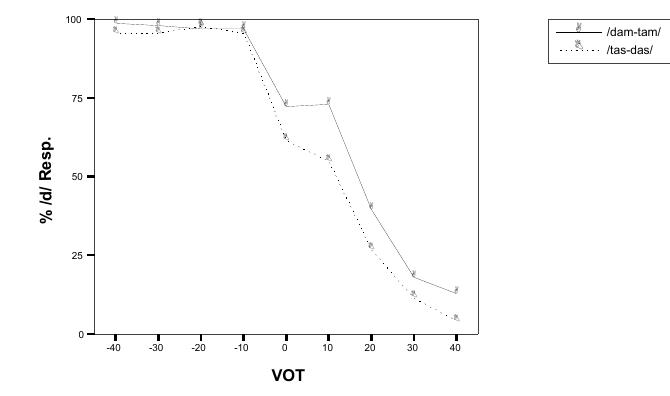
Figure 1: Results of the preliminary experiment. Percentage of voiced responses for stops in initial syllable position in two different word – nonword pairs. In /dam-tam/, /dam/ is a French word and /tam/ is a nonword. In /tas-das/, /tas/ is a French word and /das/ is a